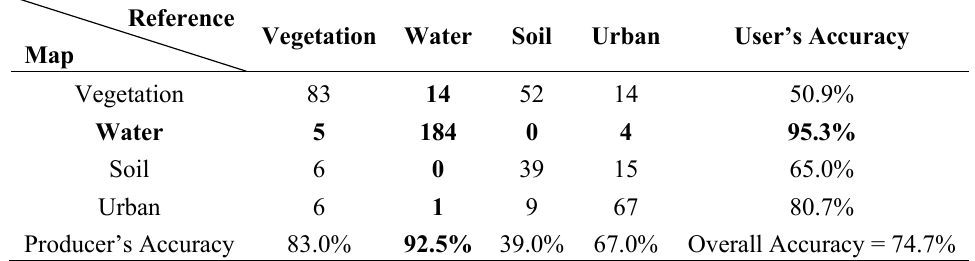
Table 3. Error matrix for after-Katrina classification, Maximum Likelihood classifier.